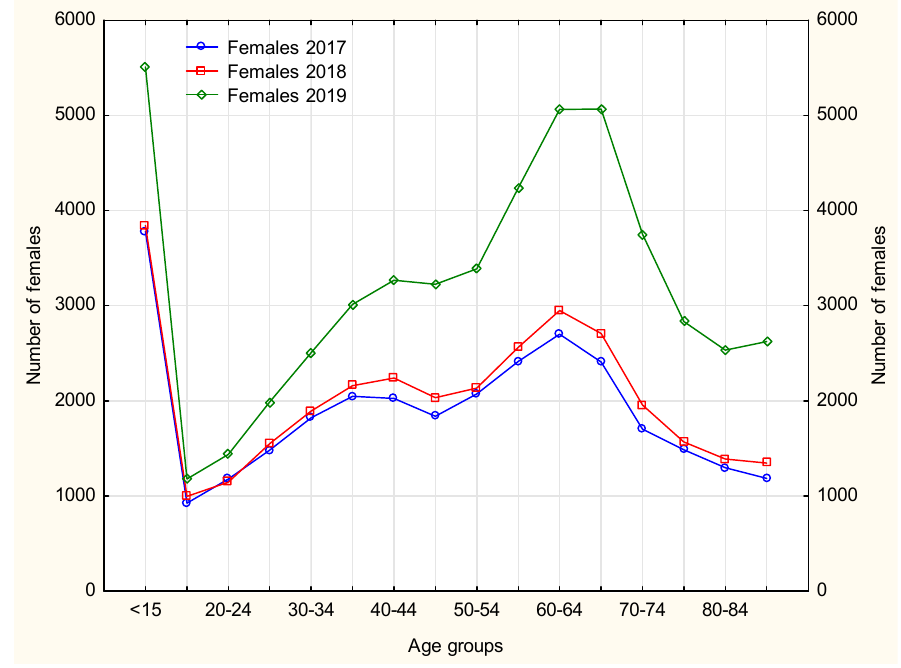
Figure 4. The number of female patients every year separately according to age groups.